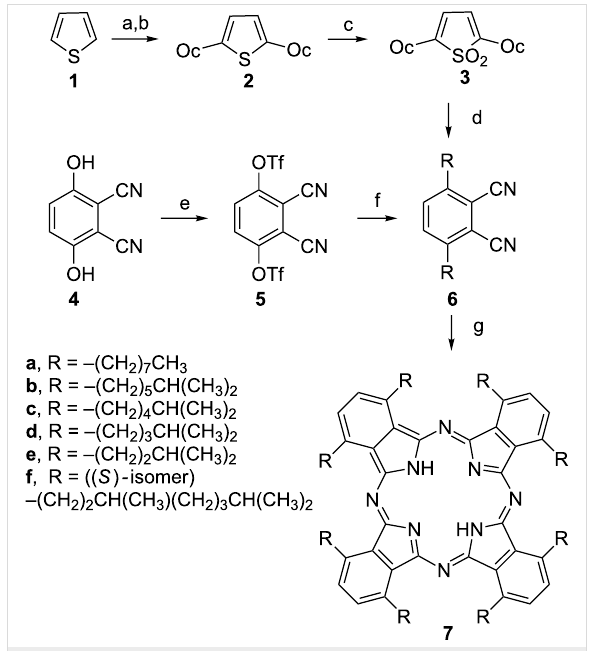
Scheme 1: (Top) original synthesis of compound 7a from thiophene (Oc = n -octyl) [19]. (Below) shortened synthesis of α -alkylated deriva- tives through the triflate of 3,6-dihydroxyphthalonitrile. Reagents: (a) BuLi; (b) C 8 H 15 Br; (c) MCPBA , 35–51%; (d) fumaronitrile/ Δ , 40–48%;